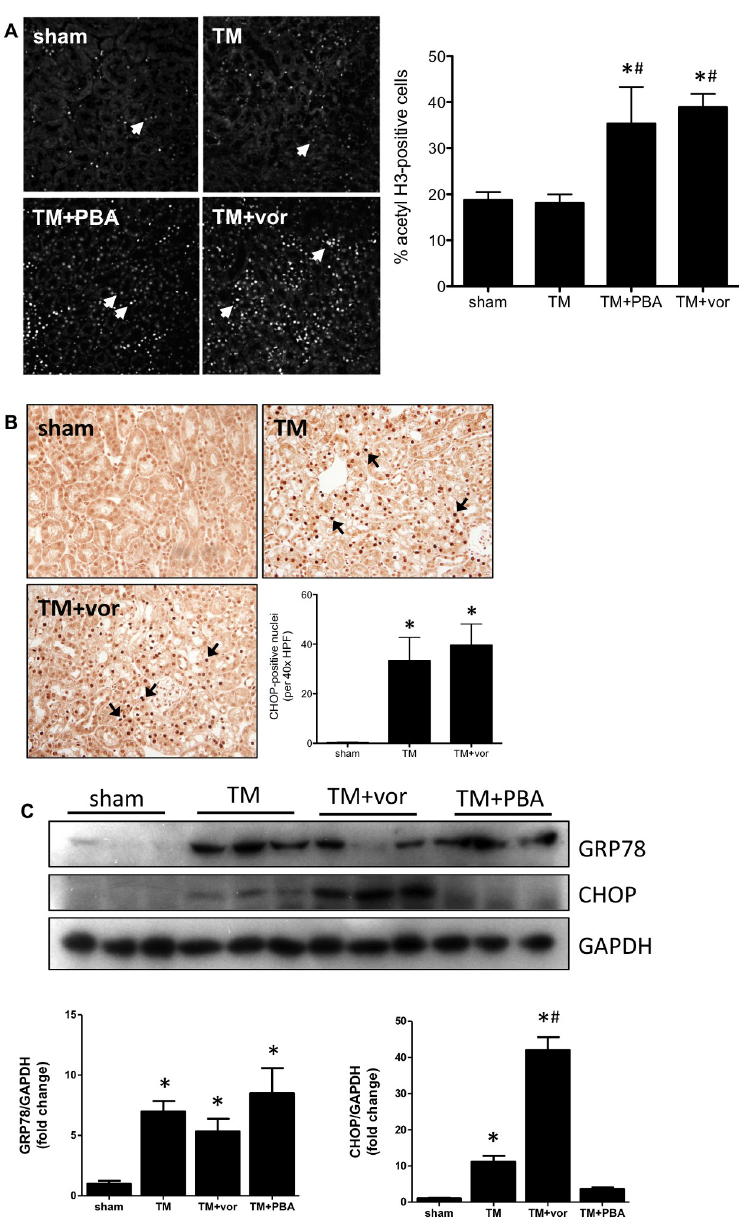
Fig 3. Wild type mice were given tunicamycin (TM; 0.5 mg/kg I.P) for 3 days with or without PBA (1 g/kg/day) or vorinostat (vor; 50 mg/kg/day). (A) Kidneys were stained for acetylated histone 3 (H3; arrows). H3 acetylation was increased in TM+PBA and TM+vor mice. (B) Kidneys were also stained for CHOP (arrows). TM induced CHOP expression, which was not prevented by vorinostat. (C) The pars recta of the kidney was isolated and underwent Western blotting for GRP78 and CHOP. GRP78 is increased in TM-treated kidneys, and not inhibited by vorinostat or 4-PBA. CHOP expression is increased in both TM and TM+vor kidneys. � , p < 0.05 vs sham; #, p < 0.05 vs